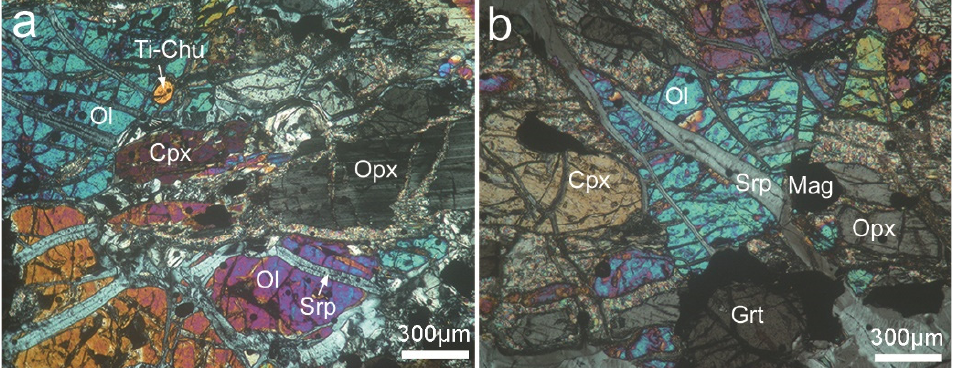
Figure 2. ( a , b ) Optical microphotographs of the garnet peridotite sample under cross polarized light mode. Abbreviations: Ol, olivine; Cpx, clinopyroxene; Opx, orthopyroxene; Grt, garnet; Srp, serpentine; Mag, magnetite; Ti-Chu, Ti-clinohumite. Table 1. Chemical composition of garnet in garnet